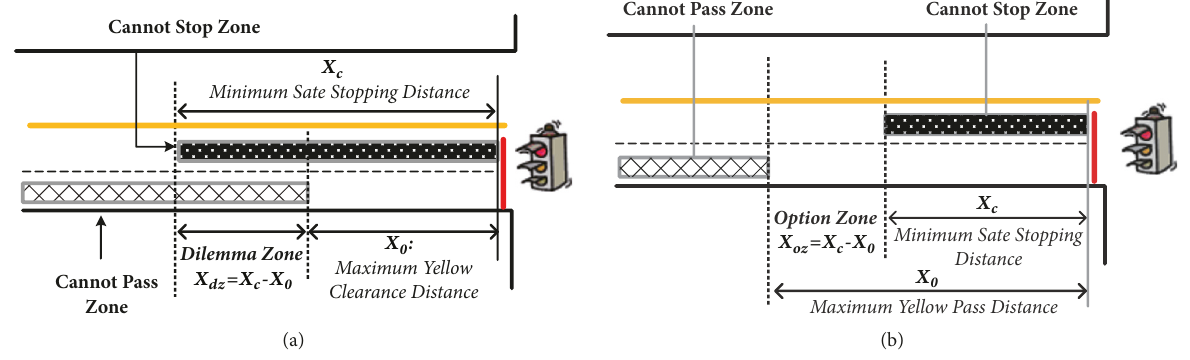
Figure 1: Formation of the dilemma zone and option zone (source literature